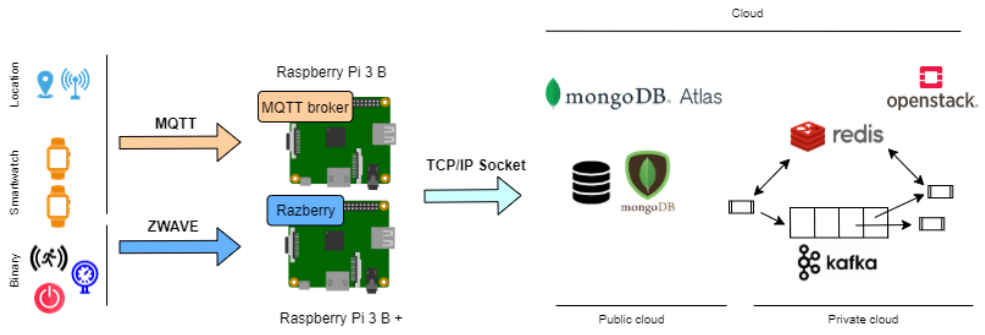
Figure 15. Infrastructure of the